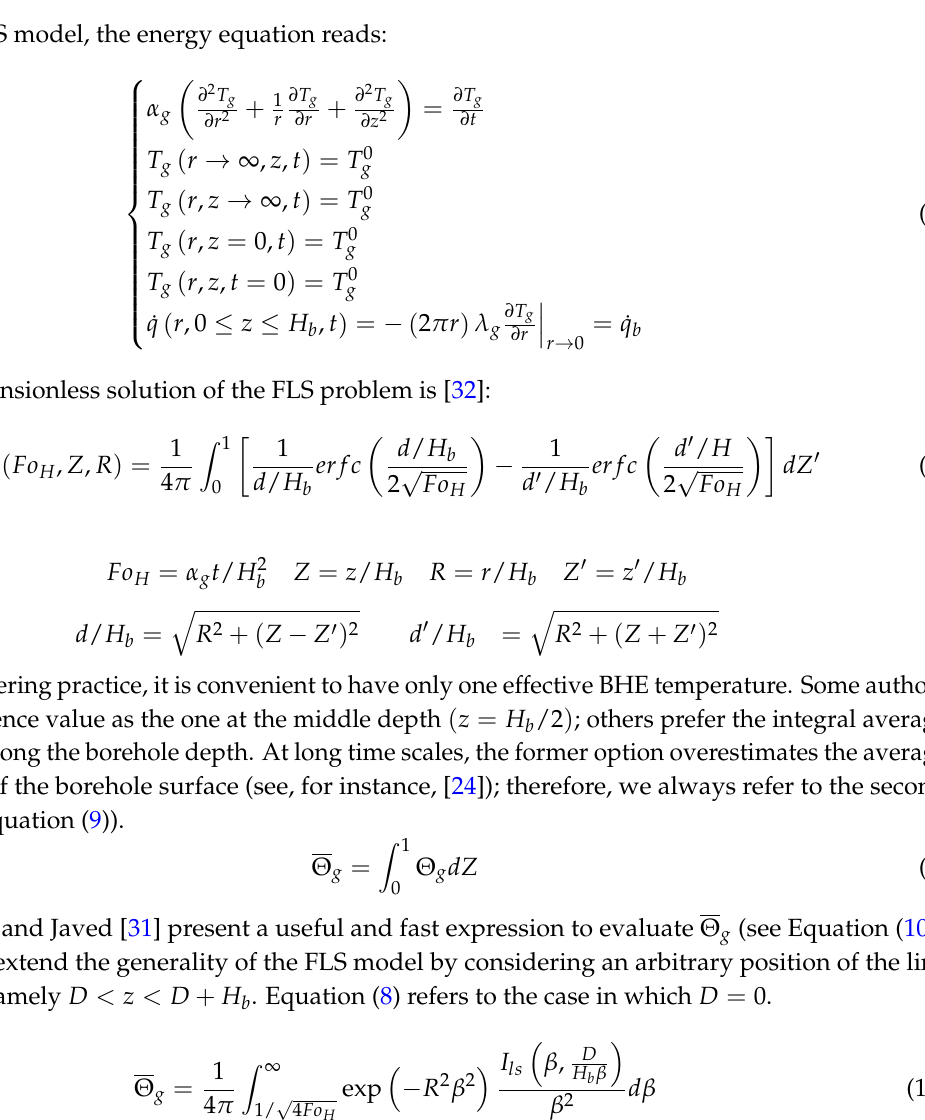
Figure 5. Schematic representation of a finite line heat source model. The surface temperature is fixed to T 0 g